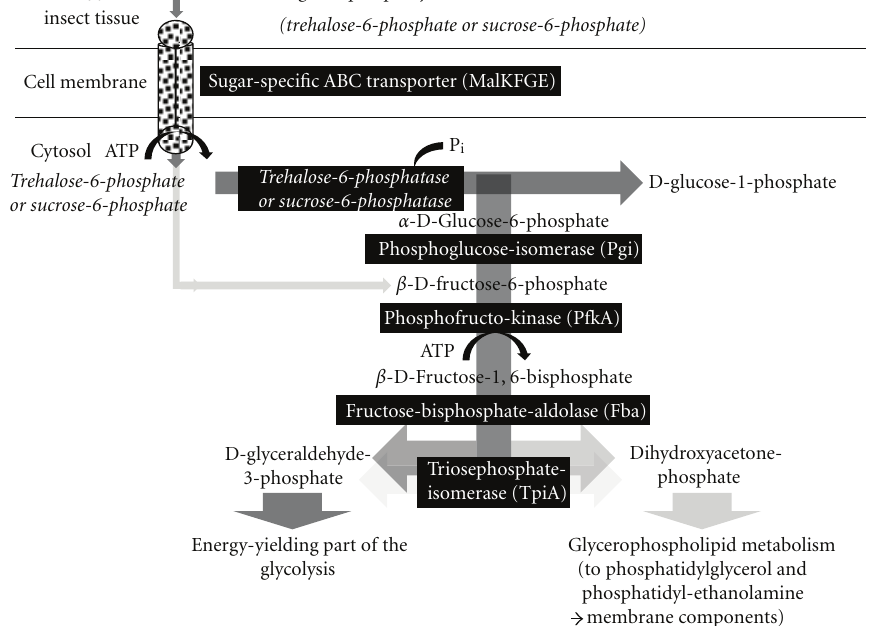
Figure 7: The sugar uptake and upper part of the glycolysis (energy investment) including trehalose-6-phosphate and β -D-fructose-6- phosphate as suggested entry substrates (steps indicated in italics).